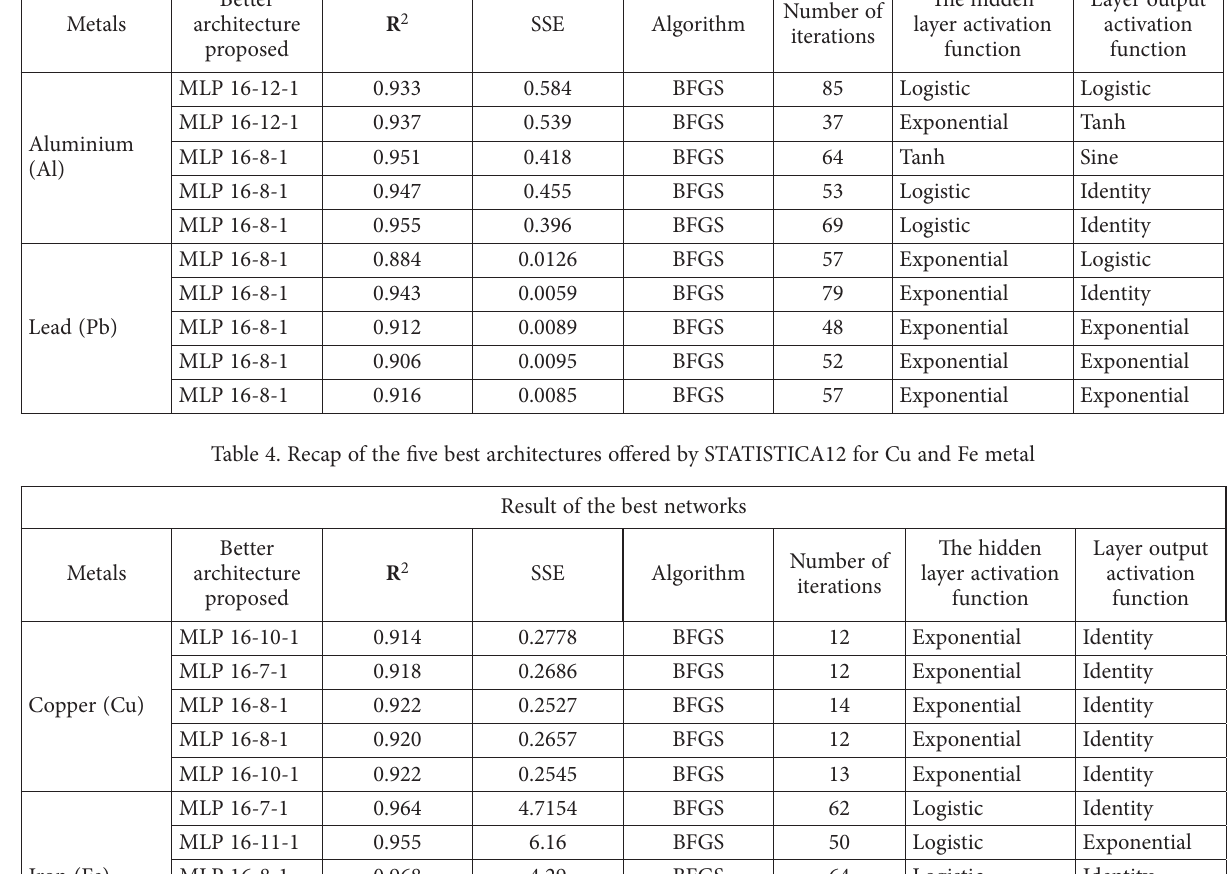
Table 3. Recap of the five best architectures offered by STATISTICA12 for Al and Pb metal Result of the best networks